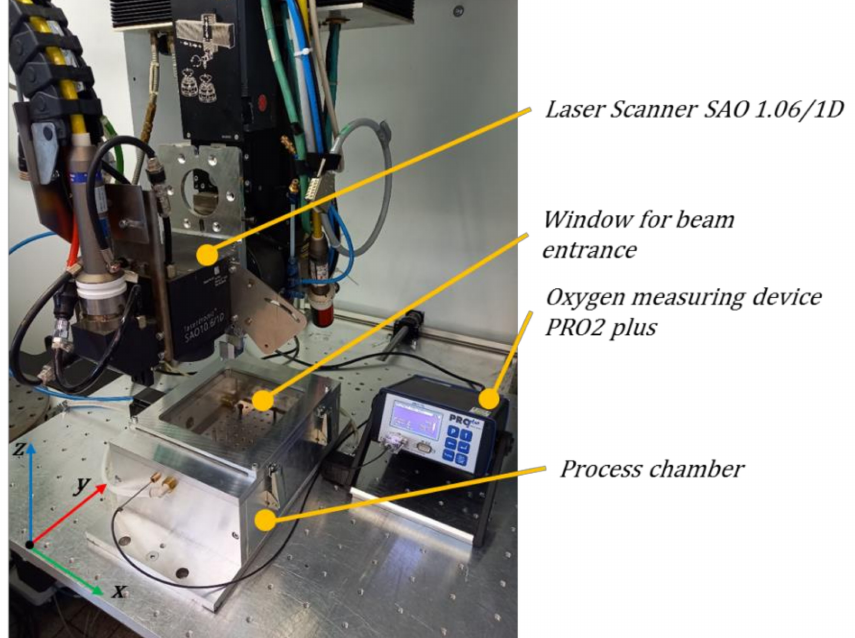
Figure 4. Experimental setup of the laser polishing in a TRUMPF Laser Cell TLC 40 with a SAO 1.06/1D scanner optics, process chamber and oxygen measurement device ORBITALSERVICE PRO2